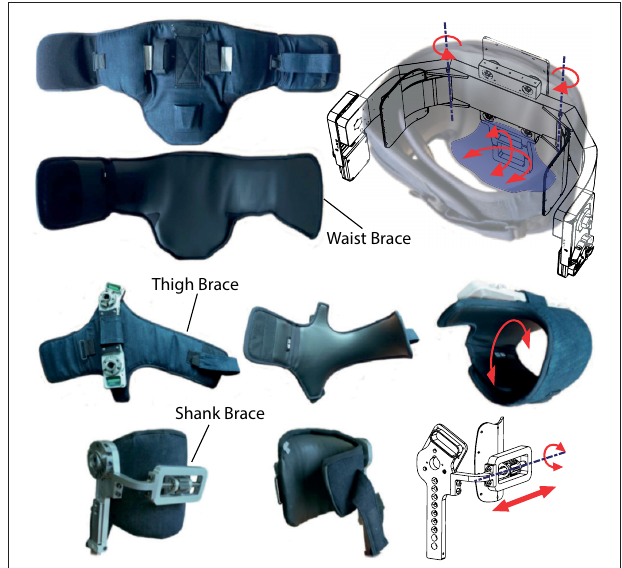
FIGURE 8 | The brace modules—The waist (top), femur (middle), and tibial (bottom) braces and their DOFs.